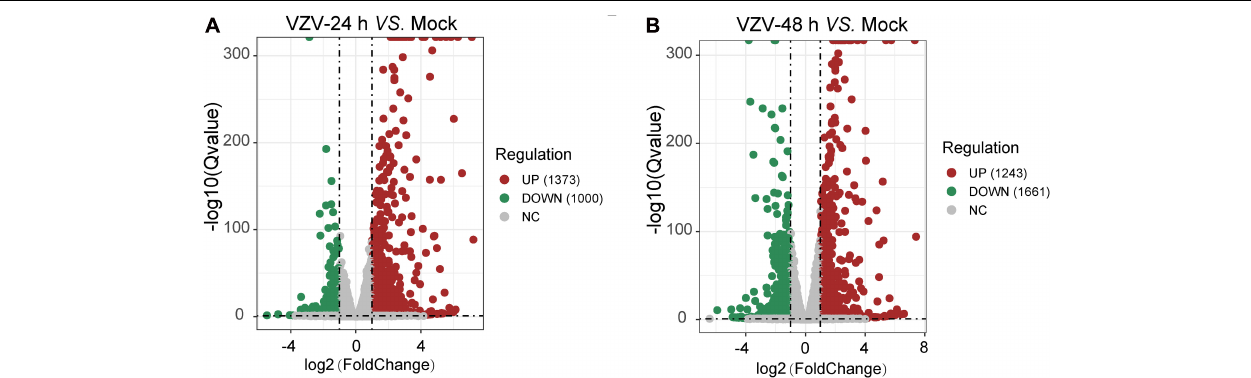
FIGURE 2 | A mass number of DEGs were induced by VZV in SH-SY5Y cells. (A) Volcanic map showed the number and distribution of DEGs in SH-SY5Y cells after 24 h of VZV infection. (B) Volcanic map showed the number and distribution of DEGs in SH-SY5Y cells after 48 h of VZV infection. Volcano map showed that VZV group had significant mRNA expression compared with mock without VZV infection. Log 2 (Fold change) and log 10 ( Q- value) of DEGs are expressed as abscissa and ordinate, respectively. The significantly upregulated genes are shown in red and the significantly downregulated genes are shown in green.